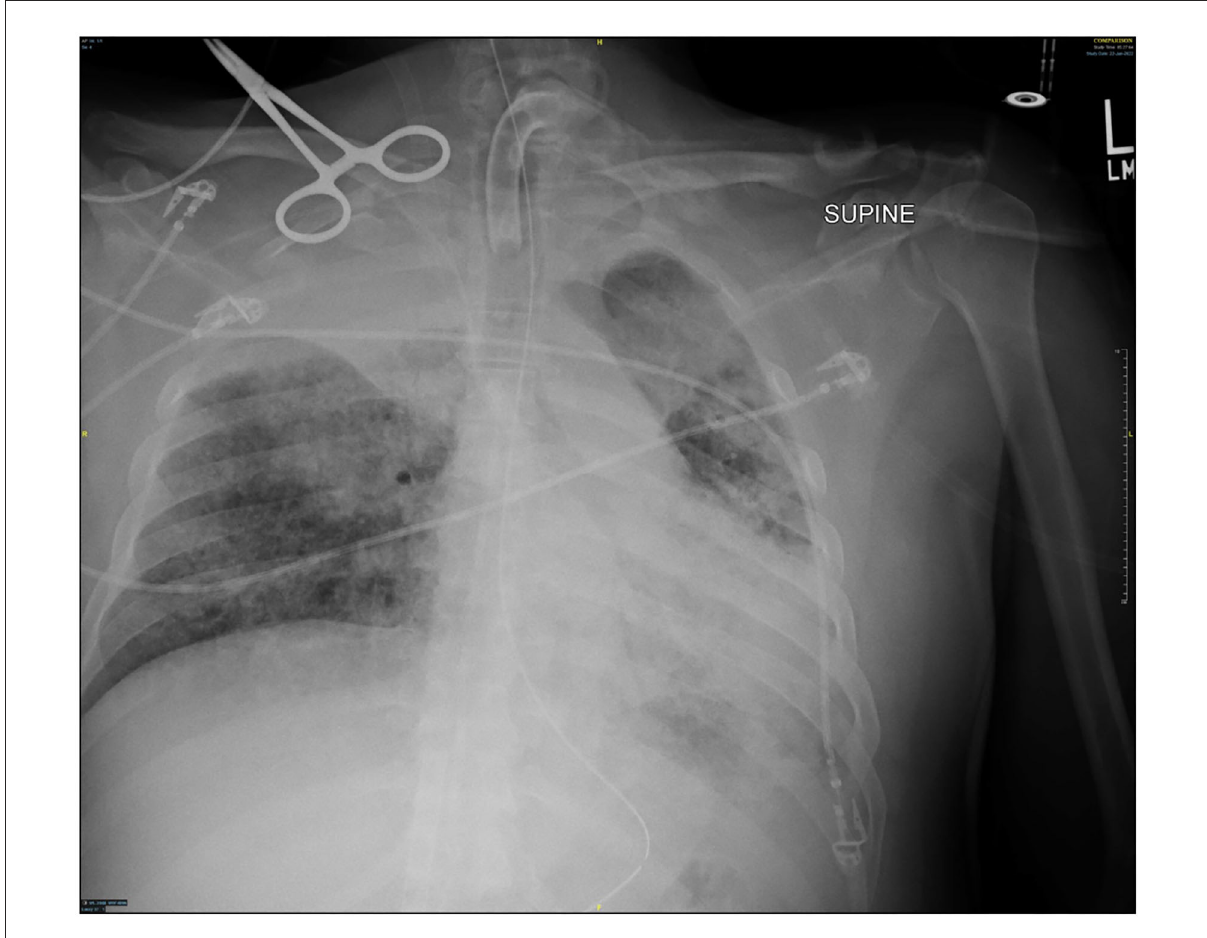
FIGURE6 Chest x-ray 4 days after resuming